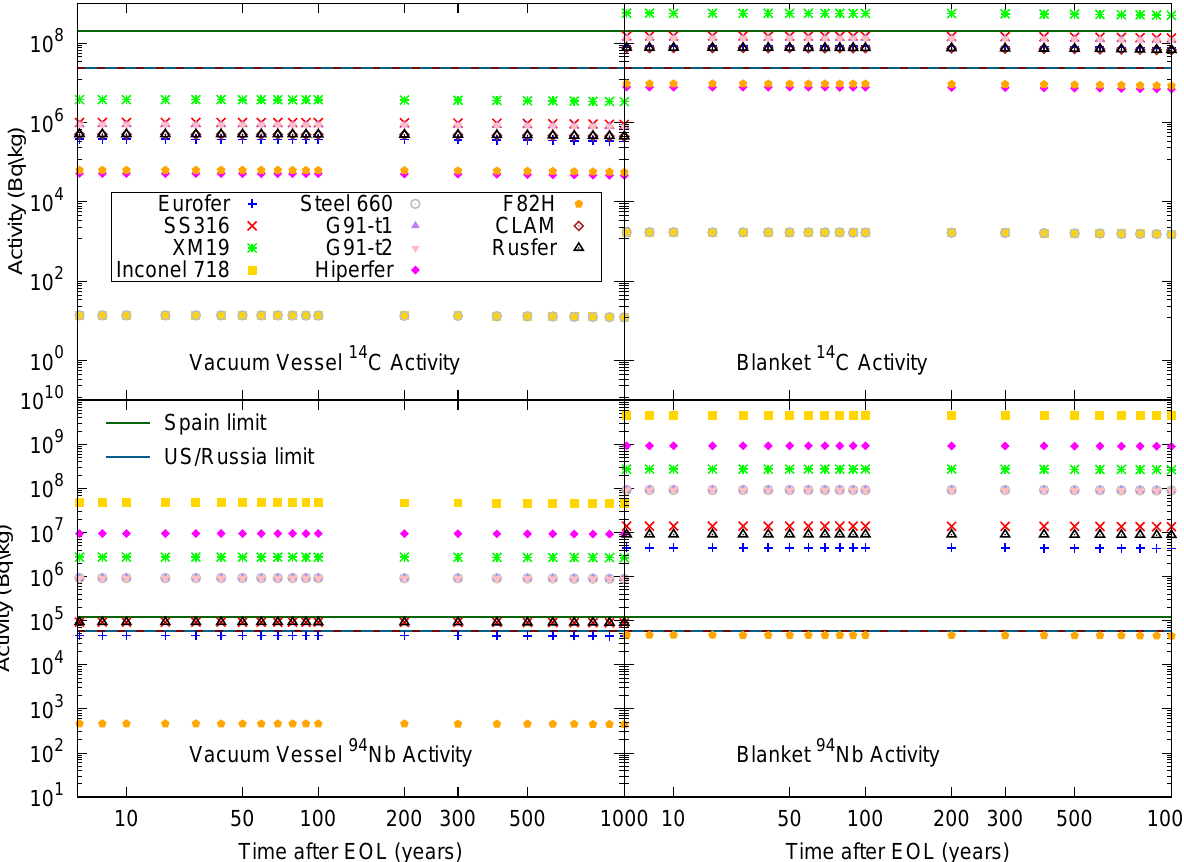
Figure 3: The activity from 14 C (upper) and 94 Nb (lower). Right panels show results for the blanket, left for the VV. The Russia and US limits are indistinguishable (table